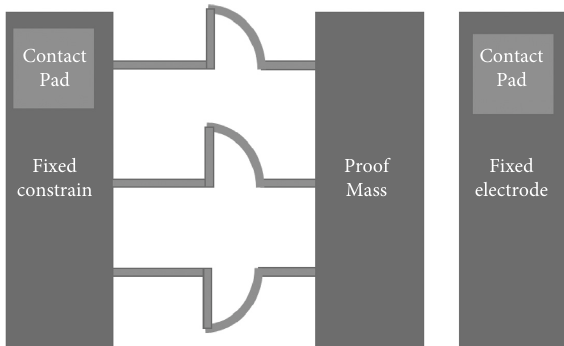
Figure 3: Proposed inertial sensor 3 with three arc beams.